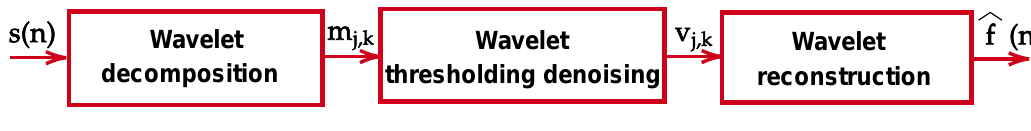
Figure 5. Wavelet Threshold Denoising Mechanism.